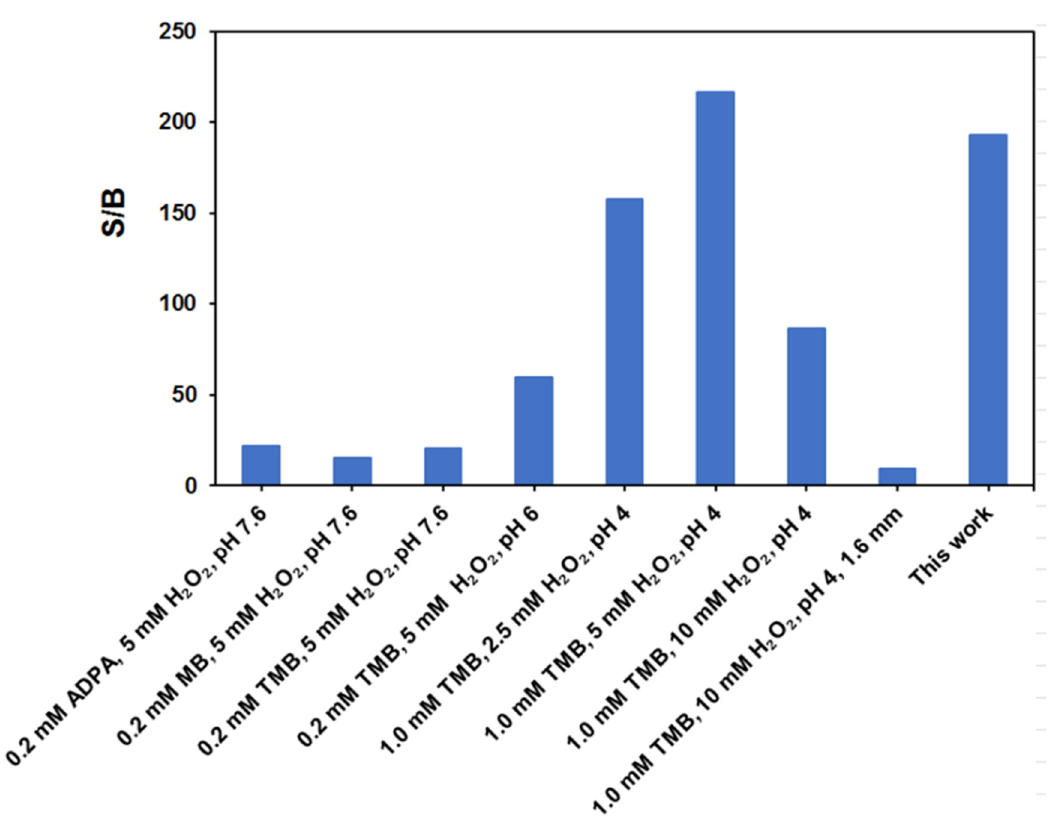
Figure 9. Comparison of the relationship between current density values obtained in the presence (1.0 μ M) and absence of synthetic target DNA (S/B ratio) provided by the biosensors described in [28–30] for columns 1,2,3–8, respectively} for the determination of toxic algae changing mediators, labels, reagent concentrations and pH along with a final change to a single probe (this study).